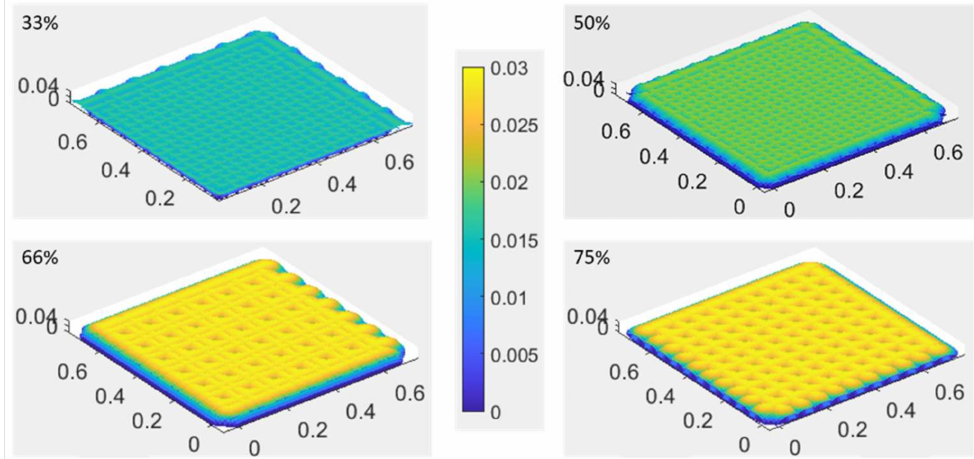
Figure 23. Illustration of the simulation of a TIFF with different coverage